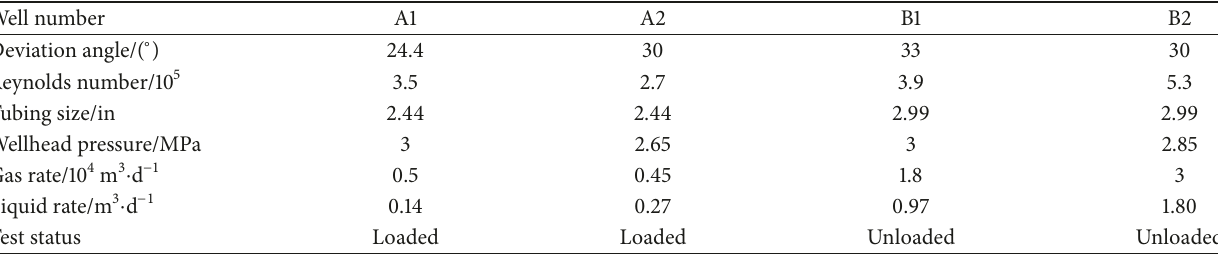
Table 5: Field data of 4 wells in northern block.